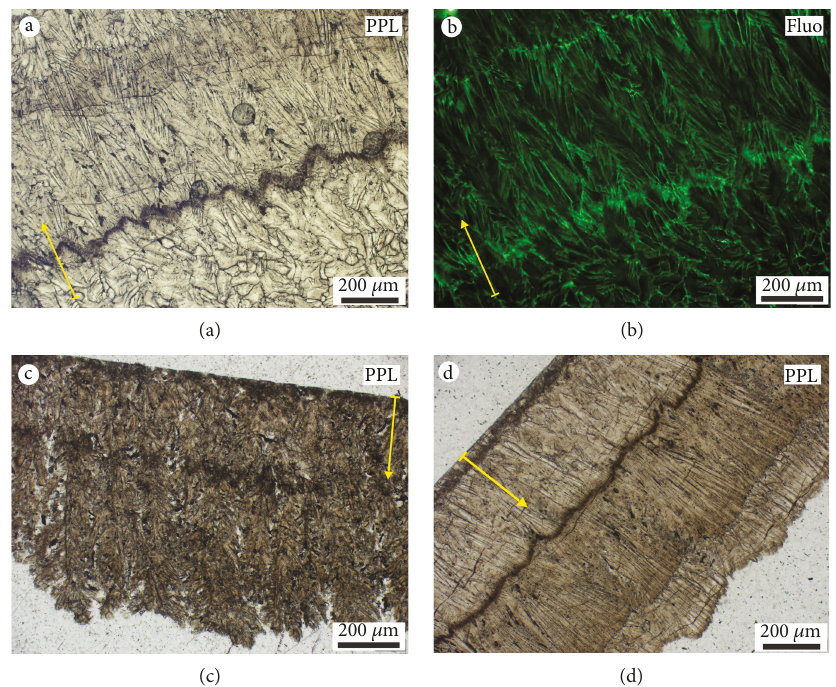
Figure 13: Inner structure of the thin carbonate scales. The growth direction is marked by yellow arrows. (a, b) Contact zone between two distinct growth zones, divided by an organic-rich, greenish fl uorescent zone (sample G-06). (c) Thin dendritic carbonate scale sampled from the surface of a pump fi lter (sample G-07). (d) Thin fi brous and bladed carbonate scale sampled from the surface of a pump fi lter (sample G-08). Abbreviations: PPL=plane polarized light; Fluo = fl